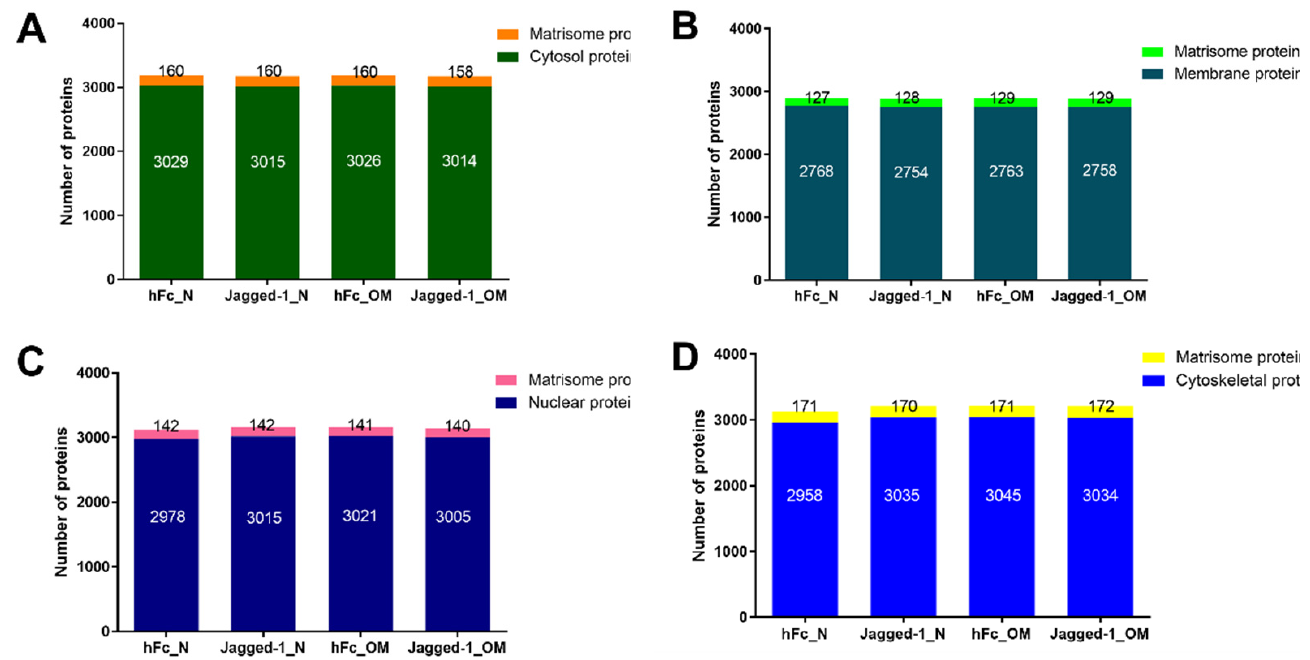
Figure 3. All cellular compartments exhibited the existence of matrisome proteins ( A – D ). The analyses were performed using the matrisome background list downloaded from http://matrisomepro- ject.mit.edu/other-resources/human-matrisome/ (accessed on 25 July 2022). Subsequently, the VLOOKUP function in Microsoft Excel (Microsoft 365, Microsoft, Washington, DC, USA) was ap- plied to subtract the matrisome proteins from subcellular proteins.